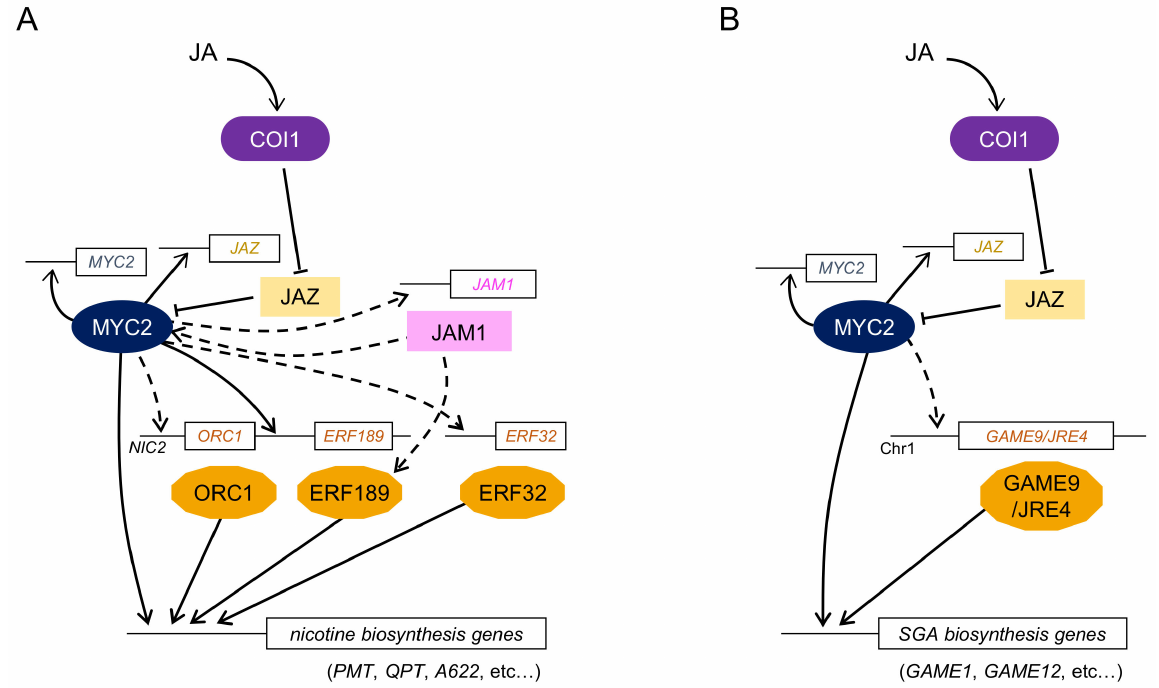
Figure 2. A simplified model of the transcriptional network of JA signaling in nicotine biosynthesis in tobacco ( A ) and SGA biosynthesis in tomato ( B ). Boxes with straight lines indicate regulator genes, including promoter regions. Black arrows indicate upregulation, while T-shaped lines indicate inhibition. Broken lines show indirect or undetermined steps that are possibly involved in uncharacterized proteins or unidentified regulation. Possible feedback regulation via MYC2 TF, which is known to regulate the expression of several JAZ genes, is shown. In tobacco, functionally redundant MYC2 proteins such as NtMYC2a, NtMYC2b, NbbHLH1, and NbbHLH2 have been identified; of these, they are collectively indicated with MYC2. ORC1 and ERF189 genes and GAME9 / JRE4 are clustered in the NIC2 locus in N. tabacum and chromosome 1 in tomato, respectively, with other group IX AP2 / ERF genes. Abbreviations: GAME, Glycoalkaloid metabolism; JAM1, JA-factor-stimulating MAPKK1; JRE4, JA-responsive ethylene response factor 4; PMT, Putrescine N -methyltransferase; QPT, Quinolinic acid phosphoribosyltransferase; SGA, Steroidal